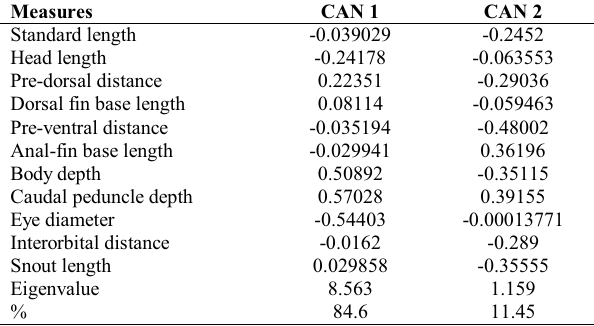
Table 2. Weight of the variables in the first two axes of the size-free canonical variate analysis (CAN1 and CAN2) of the combined Astyanax aff . fasciatus samples from Furna 2, rio Tibagi, lagoa Dourada and rio Cara-cará.